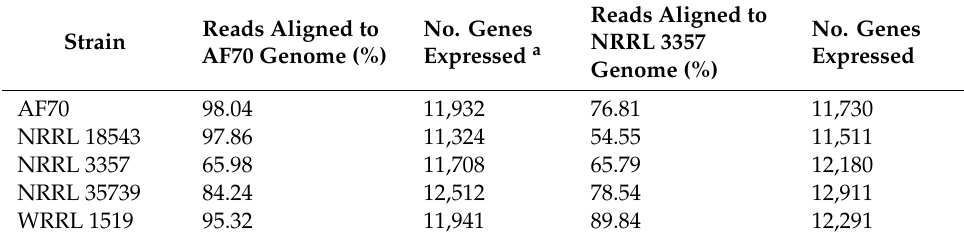
Table 3. Mapping of A . flavus RNA-Seq reads .